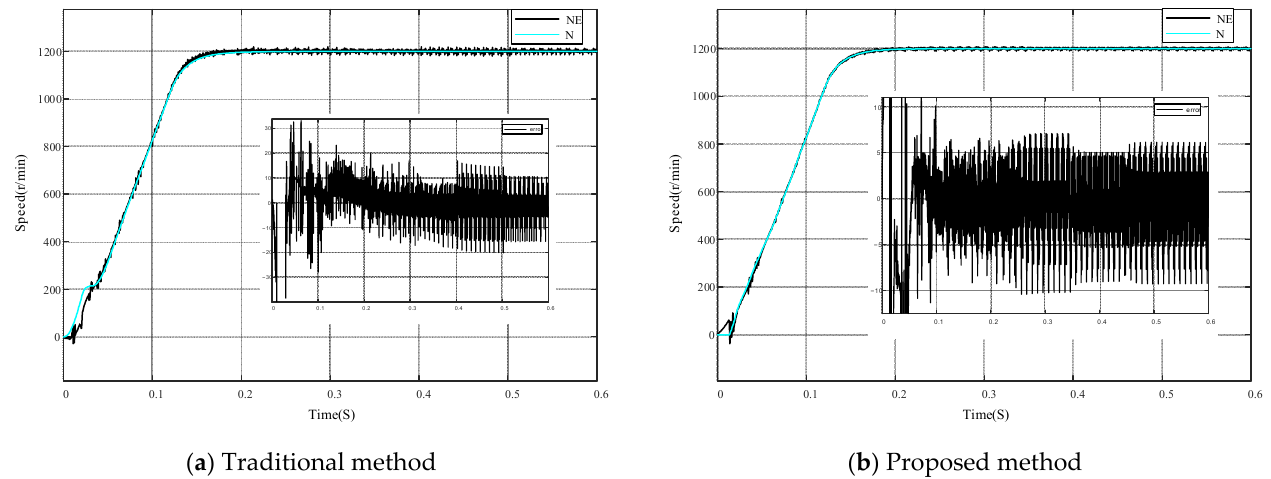
Figure 6. Actual and estimated speed waveforms at 1200 r/min. In Figure 7, the motor speed is suddenly changed from 1000 r/min to 1200 r/min. When the motor speed changes, the speed estimation error in Figure 7a is 10 r/min, while the speed estimation error in Figure 7b is 6 r/min, the speed change time is not much different, about 0.05 s.